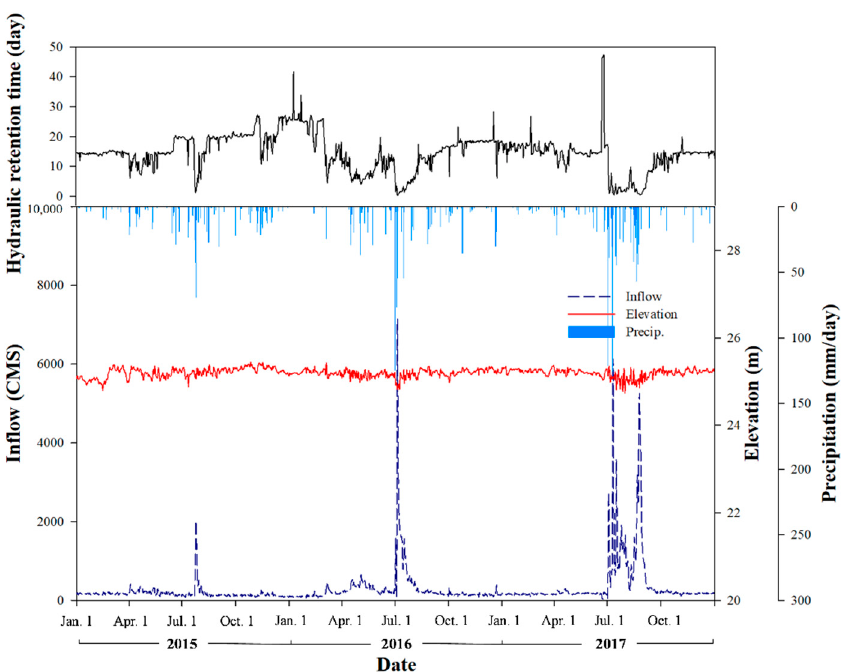
Figure 2. Seasonal changes in the inflow, elevation, precipitation, and hydraulic retention time (HRT) for Lake Paldang from 2015 to 2017.